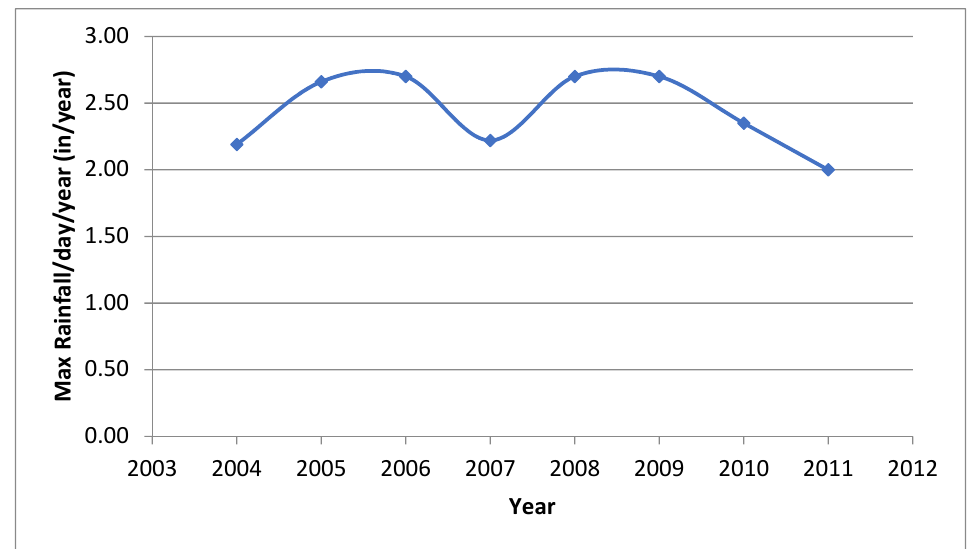
Figure 2. Maximum rainfall per day per year (in/year).